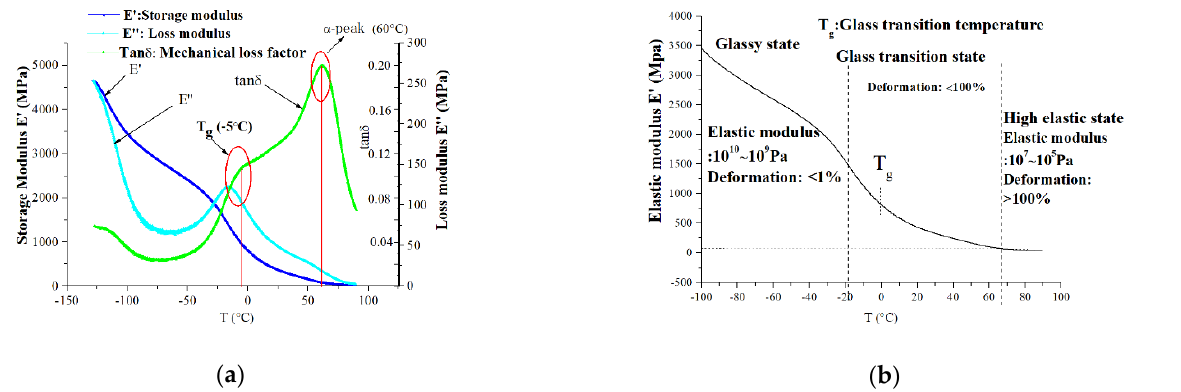
Figure 6. DMA (dynamic mechanical analysis) spectrum of new XLPE specimen: ( a ) DMA spectrum of new XLPE specimen; ( b ) Mechanical states at different temperatures.